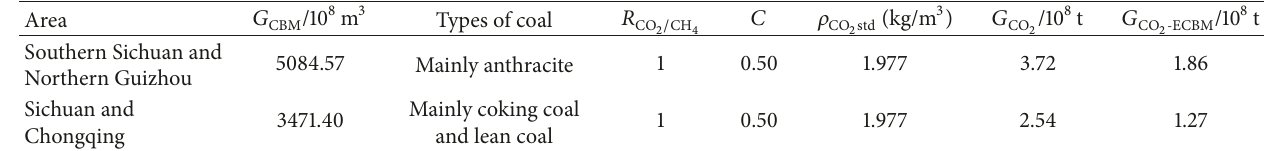
Table 11: Storage potential of CO 2 in unmineable coal seams and CO 2 -ECBM in the Sichuan Basin.